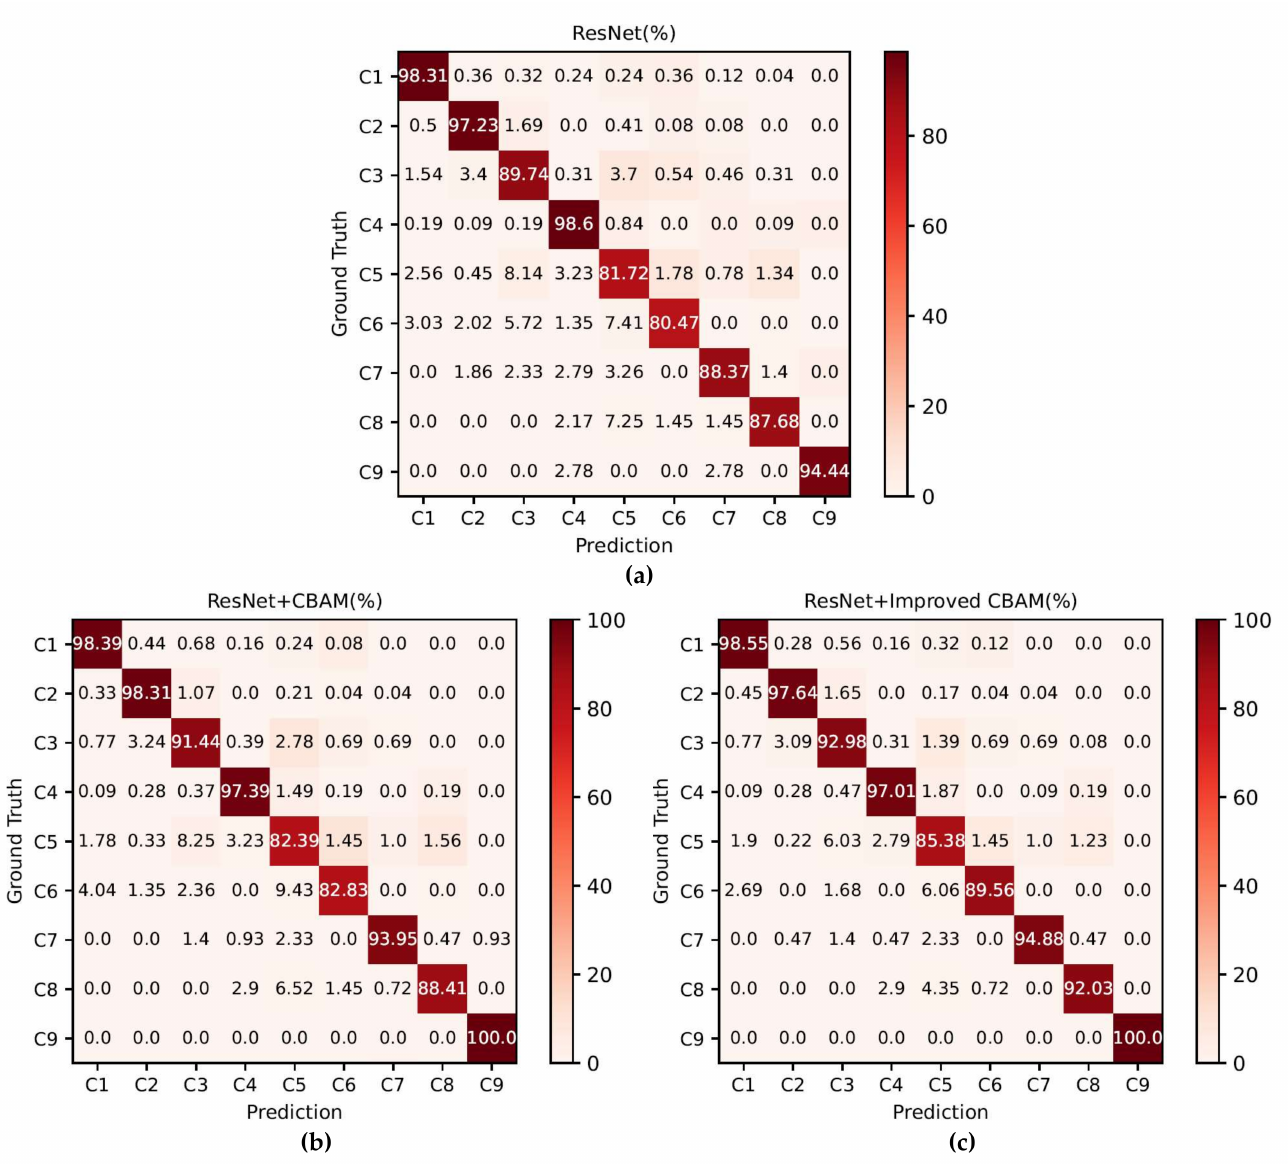
Figure 12. The classification confusion matrixes on test set(C1: None , C2: Edge-Ring , C3: Edge-Local , C4: Center , C5: Local , C6: Scratch , C7: Random , C8: Donut , C9: Near-Full ). ( a ) Training based on ResNet. ( b ) Training based on ResNet and the original CBAM attention mechanism. ( c ) Training based on ResNet and Improved CBAM attention